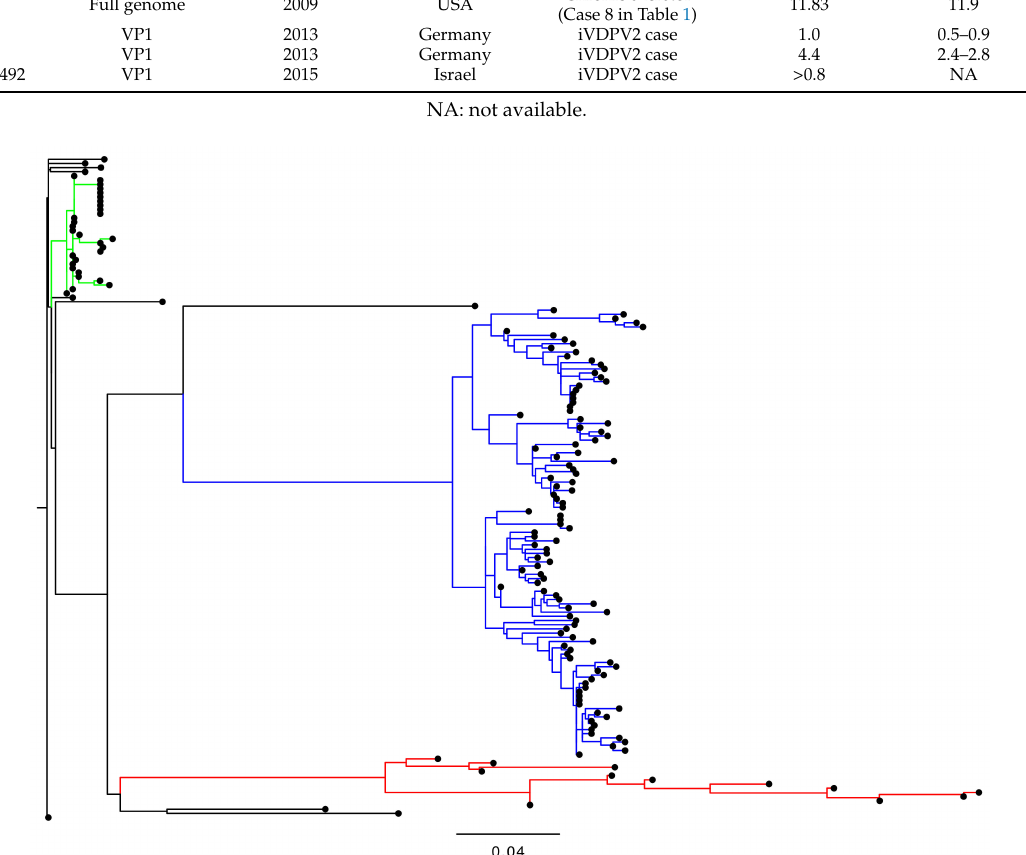
Figure 1. The phylogenetic tree of VP1 sequences in 157 iVDPV2 isolates. The sequence alignment was constructed using Clustal Omega, and the tree was inferred using the FastTree 2.1.10 [48] with the GTR model and gamma distribution and visualized with FigTree. Large genetic clusters of each case study are indicated by different colors, red for a chronic excretor in the United Kingdom 1995–2013 [45], blue for the environmental samples from Slovakia in 2003–2005 [43], and green for the stool and oropharyngeal samples from Israel in 2018